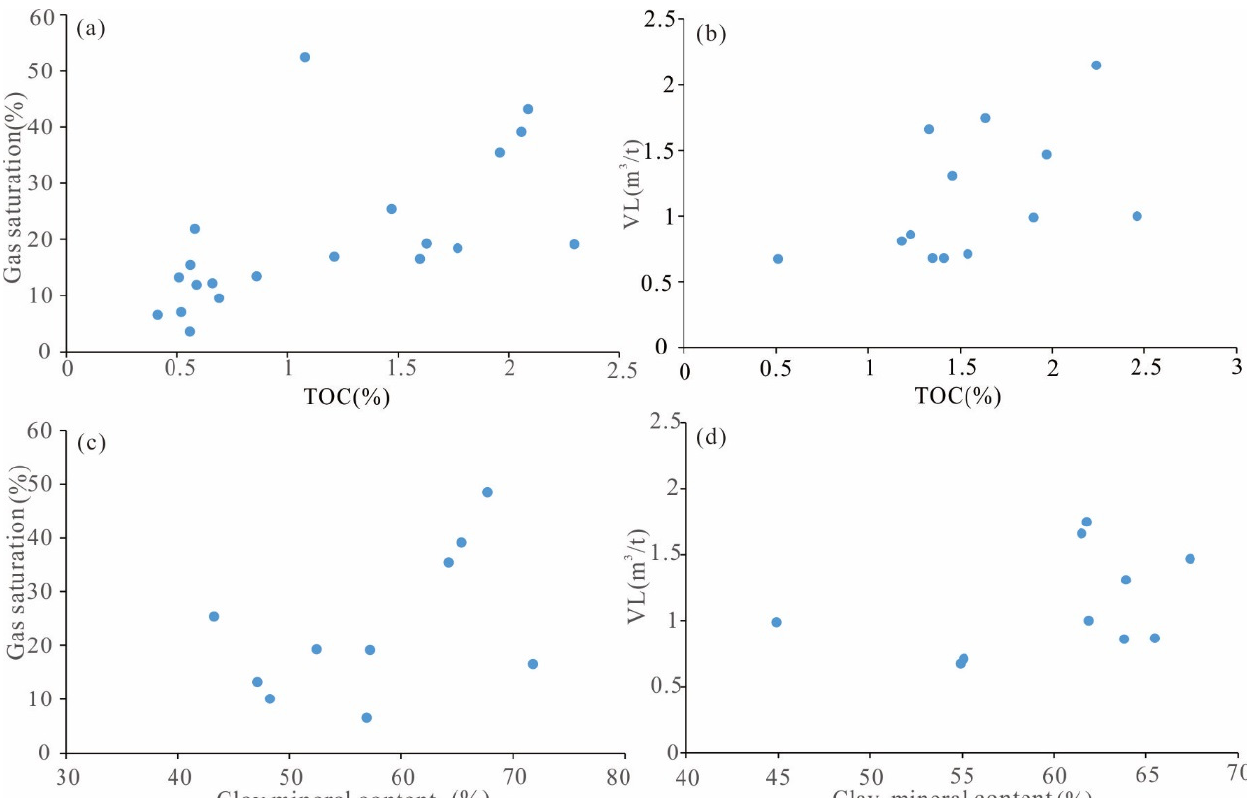
Figure 9. Effects of organic pores ( a , b ) and clay-mineral pores on gas saturation and adsorption capacity ( c , d ) in the Dongyuemiao lacustrine-shale samples. The VL represents Langmuir volume. However, as mentioned above, the water in clay mineral pores has a negative effect on the adsorption capacity. The molecular-dynamics simulation suggested that the gas density in illite surfaces decreases significantly when the water saturation increases from 0 to 90% (Figure 10). The simulated adsorbed gas accounts for 31.82% at a water saturation of 0, and it is only 19.31% at a water saturation of 90%, which is a decreased of 39.32%. This suggests that adsorption behavior mainly occurred between illite and gas when the water saturation is low, and that it mainly occurs between water film and gas when the water saturation is high. The measured water saturation in the Dongyuemiao lacustrine shale samples was between 40% and 90%, indicating the minor contribution of the clay minerals to the adsorption